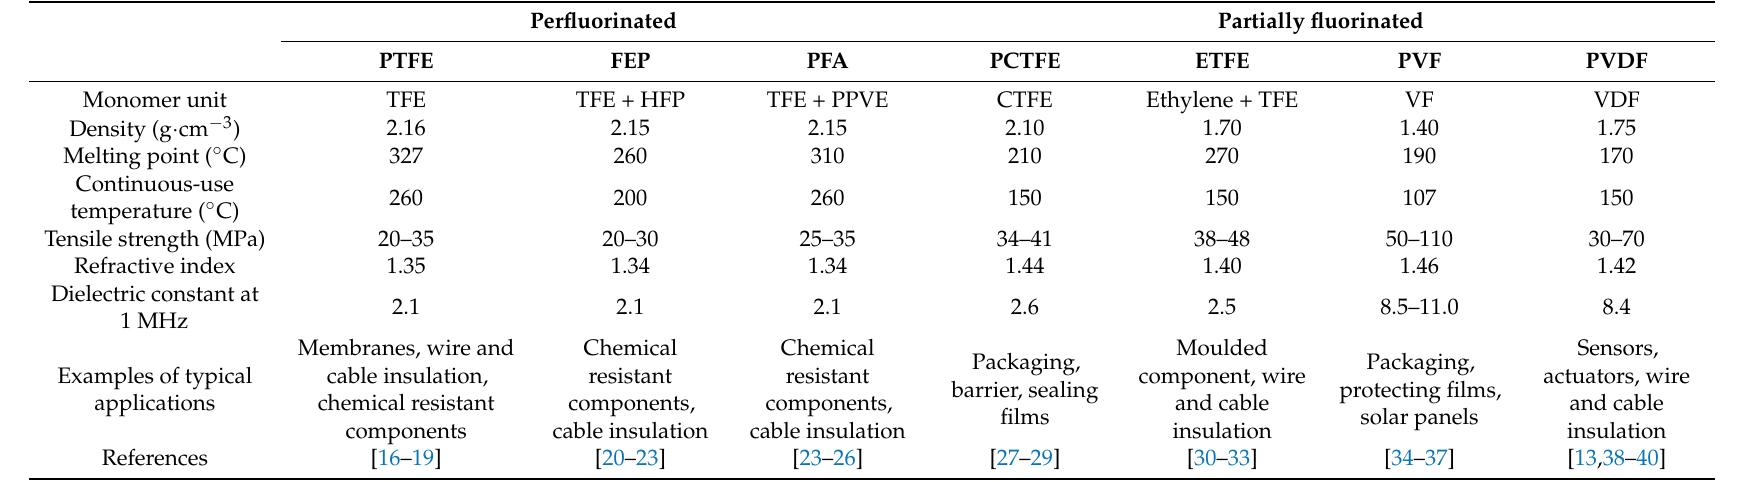
Table 1. Typical properties of commercial fluorinated